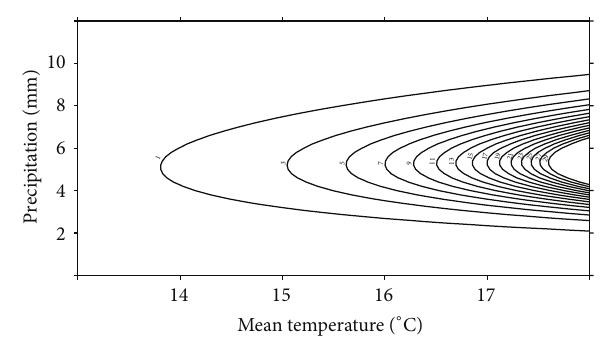
Figure 4: Contour plot of predicted numbers of migrating T. crista- tus per observation unit, as a function of daily mean temperatures in ∘ C ( 𝑥 -axis) and accumulated daily precipitation in mm ( 𝑦 -axis). Maximum numbers of migrators are restricted to 20 individuals in the plot to ease visualization.